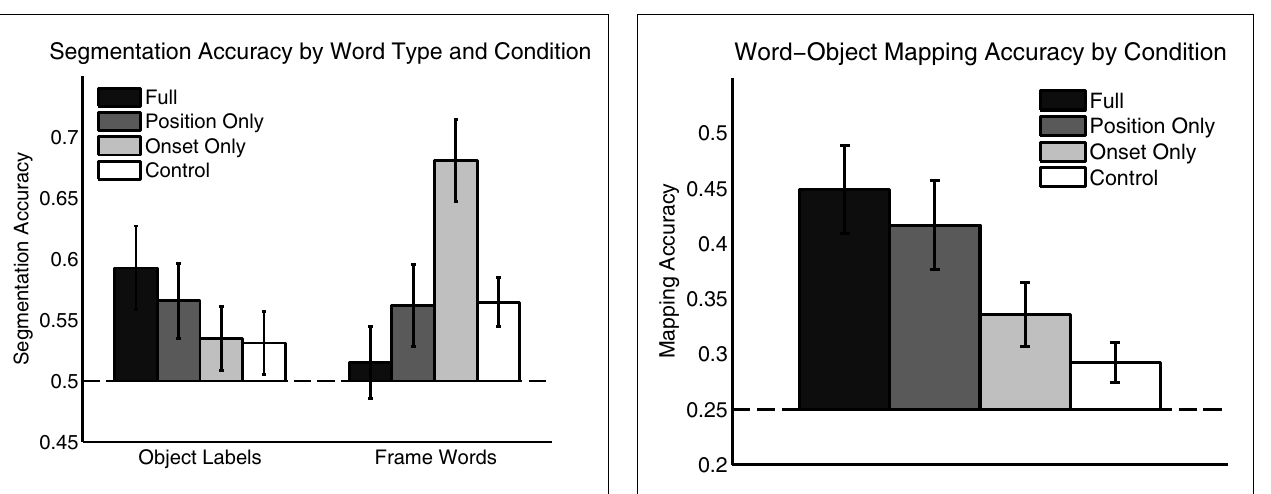
FIGURE 3 |Word-object mapping accuracy by condition. Participants mapped words onto object successfully in all but the Control language condition. Error Bars indicate ± 1